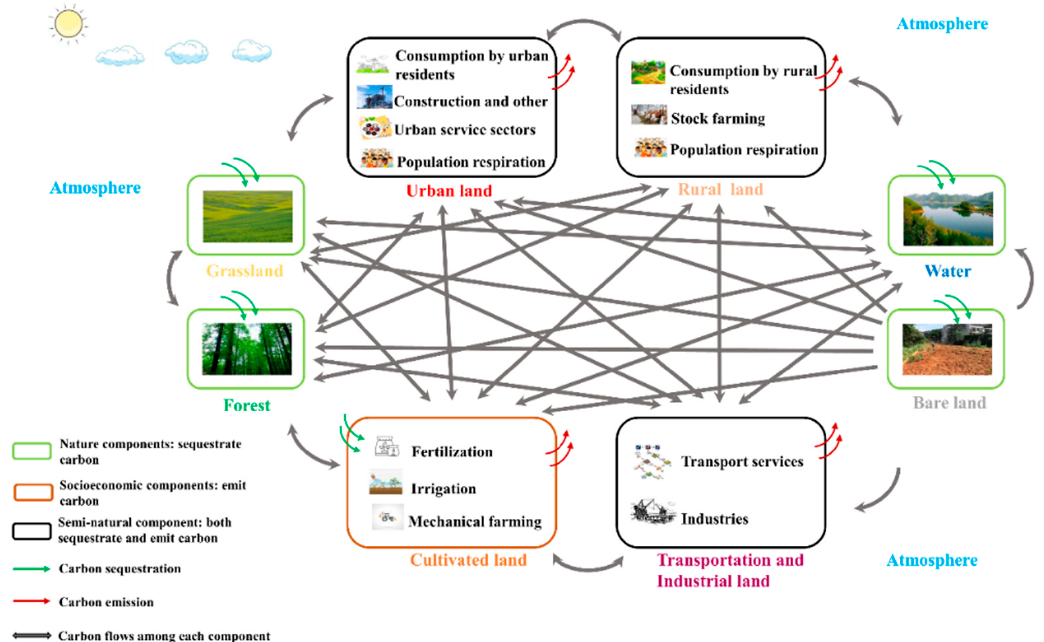
Figure 1. Framework for the urban carbon metabolic network used to study the effects of land-use change on the potential to achieve carbon neutrality. Note: the sub-processes in the red and black boxes show various socioeconomic activities causing carbon emissions. Carbon density of each socioeconomic land area was estimated by the sum of emissions from all the sub-processes dividing its corresponding land area. The red and green arrows represent the carbon exchange between atmosphere and biosphere. The black arrow represents carbon transitions between two components.